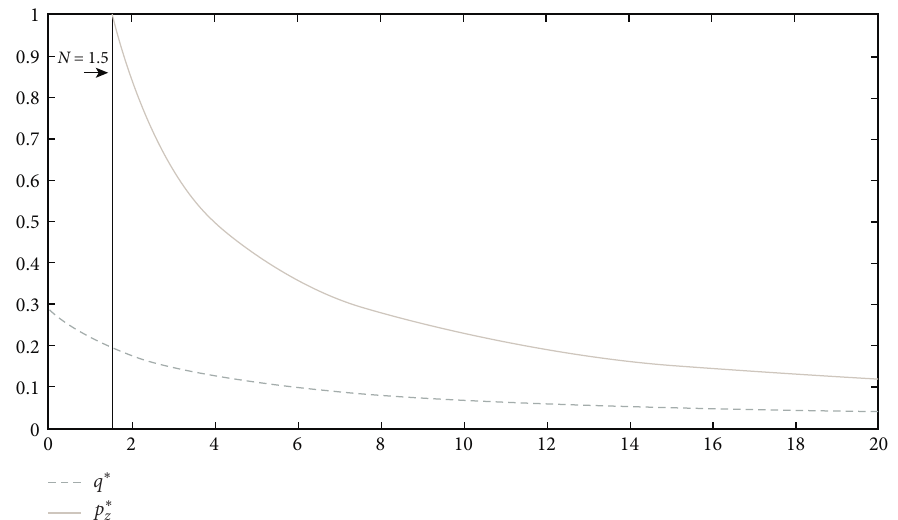
Figure 7: Simulation diagram of the influence of punishment intensity N on optimal rent-seeking probability q ∗ and optimal supervision probability p ∗ z .